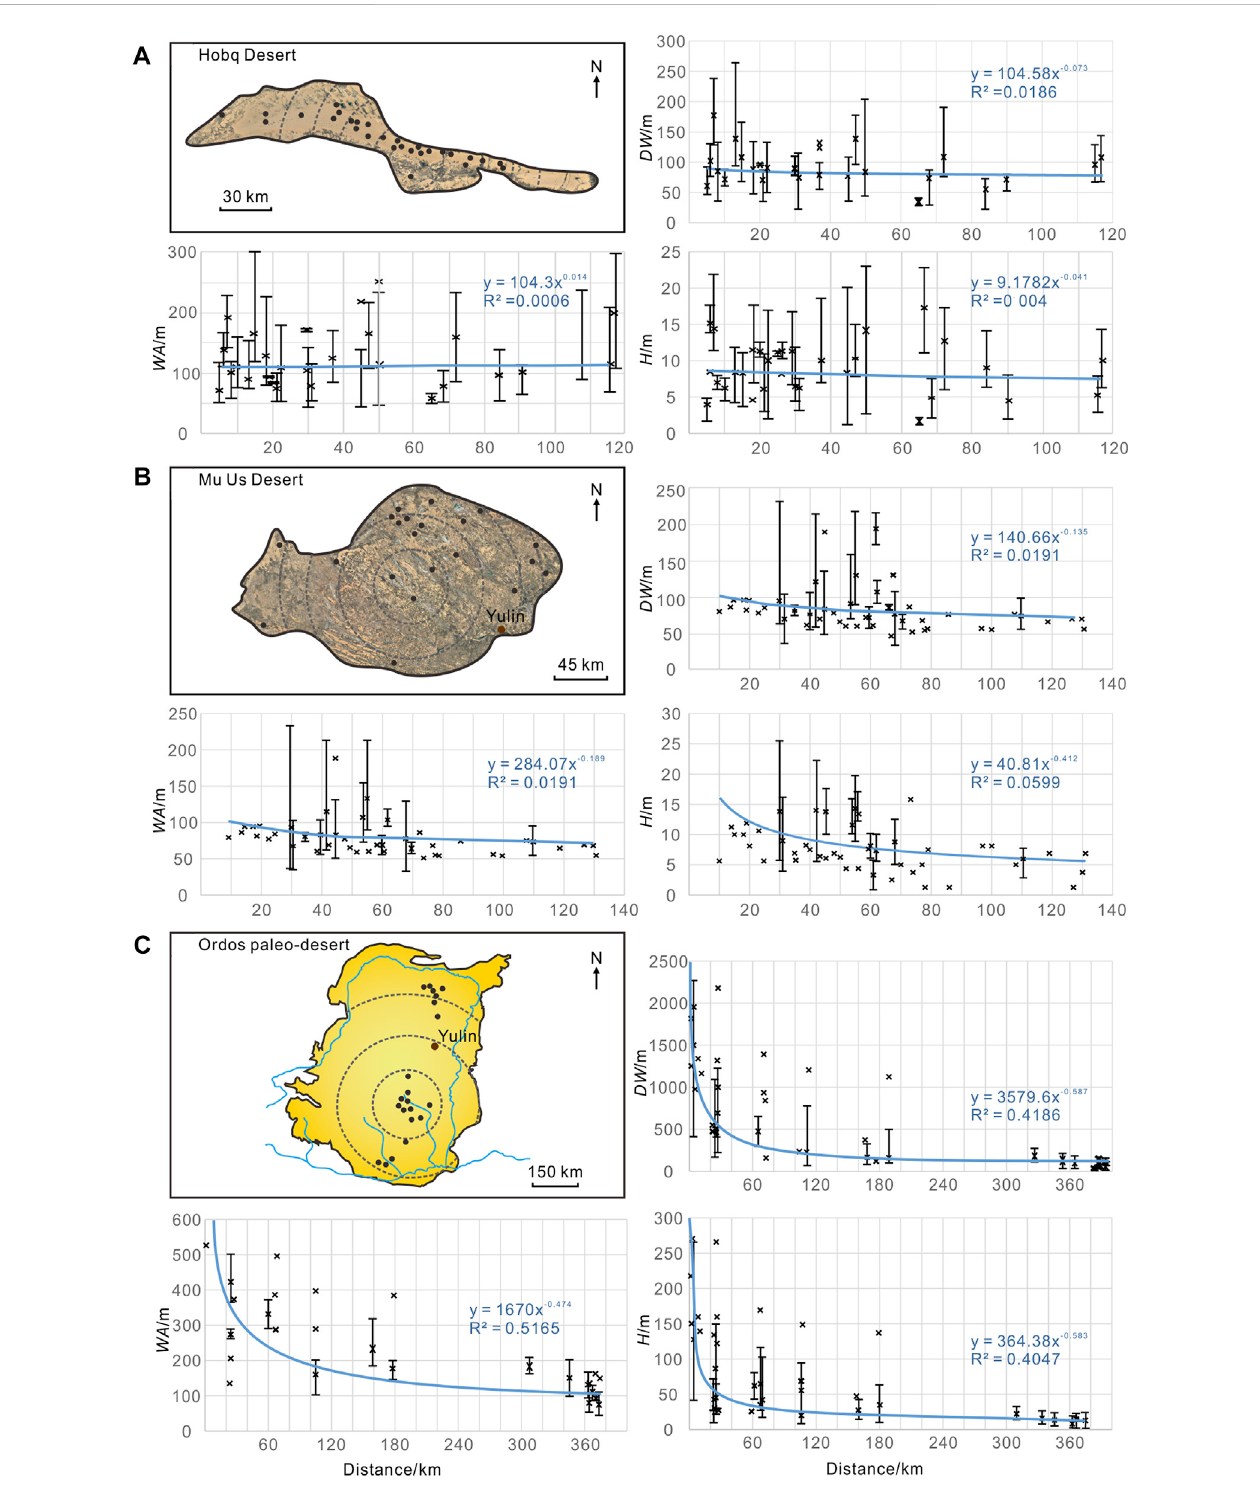
FIGURE 5 Outline map and graph ofdune wavelength( DW ), dune wavewidth ( WA )and dune height ( H )against distance from thedesertcenter intheHobq Desert (A) , Mu Us Desert (B) , and paleo-desert (C) in the Ordos Basin. The dotted circle (from the center to the boundary) corresponds to the center of the desert to themargin;blackcirclesshowlocationswheredatawascollectedandmeasurementsweretaken;bluelinesarethe fi ttingcurveswiththeequationoftheline and R 2 value also shown. The line segments in the graphs represent the range of values. All the statistical dunes consist of simple and compound crescentic